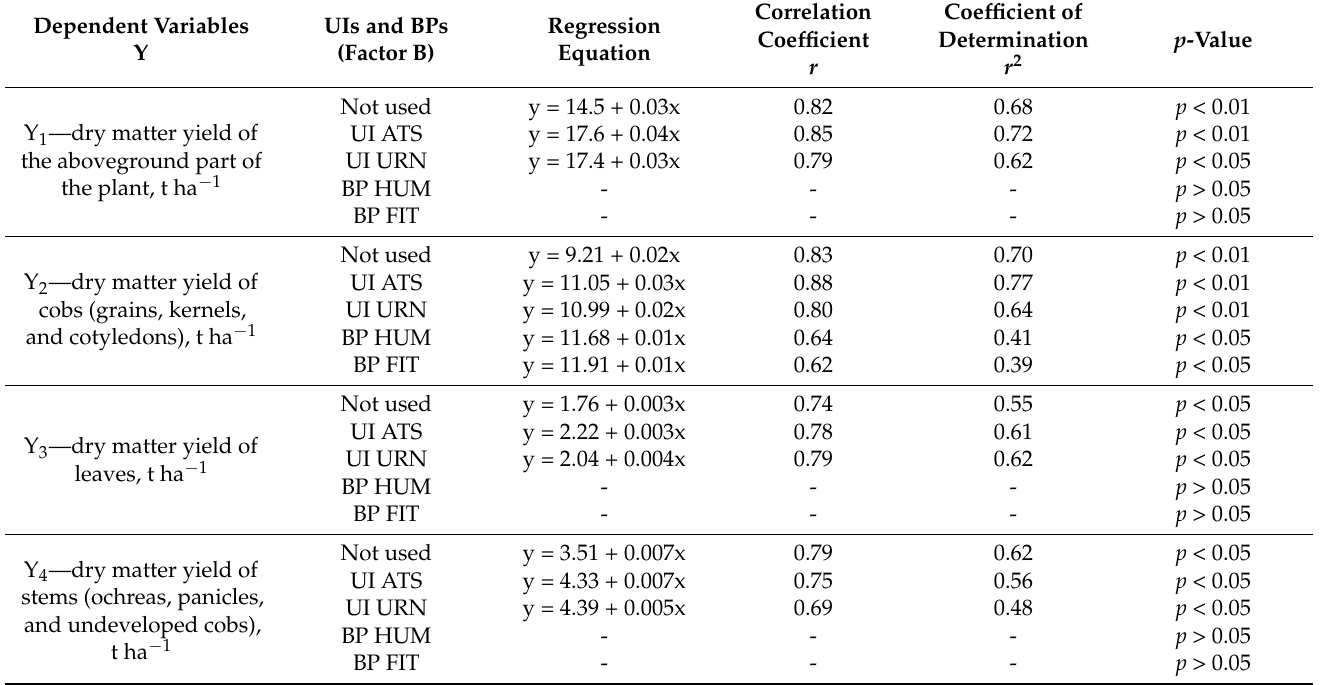
Table 10. Dependence of maize productivity on nitrogen fertilizer rates (factor A: x—kg ha − 1 ) in